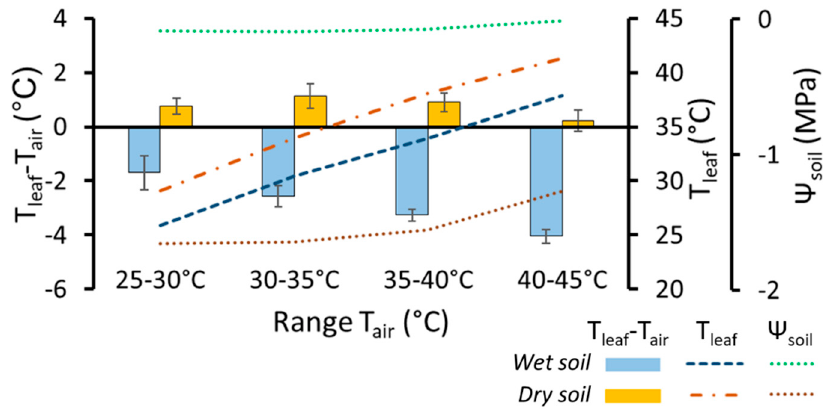
Figure 8. Example of the contrasting effect of elevated ambient temperatures ( T air ) on midday leaf temperature ( T l eaf ), under optimal (“Wet”) or suboptimal (“Dry”) soil water conditions, as indicated by soil water potential ( Ψ soil ). Measurements were performed on three adult trees of Q. ilex subsp. rotundifolia , grown in an experimental tree orchard at CITA (Zaragoza, Spain) (unpublished results).